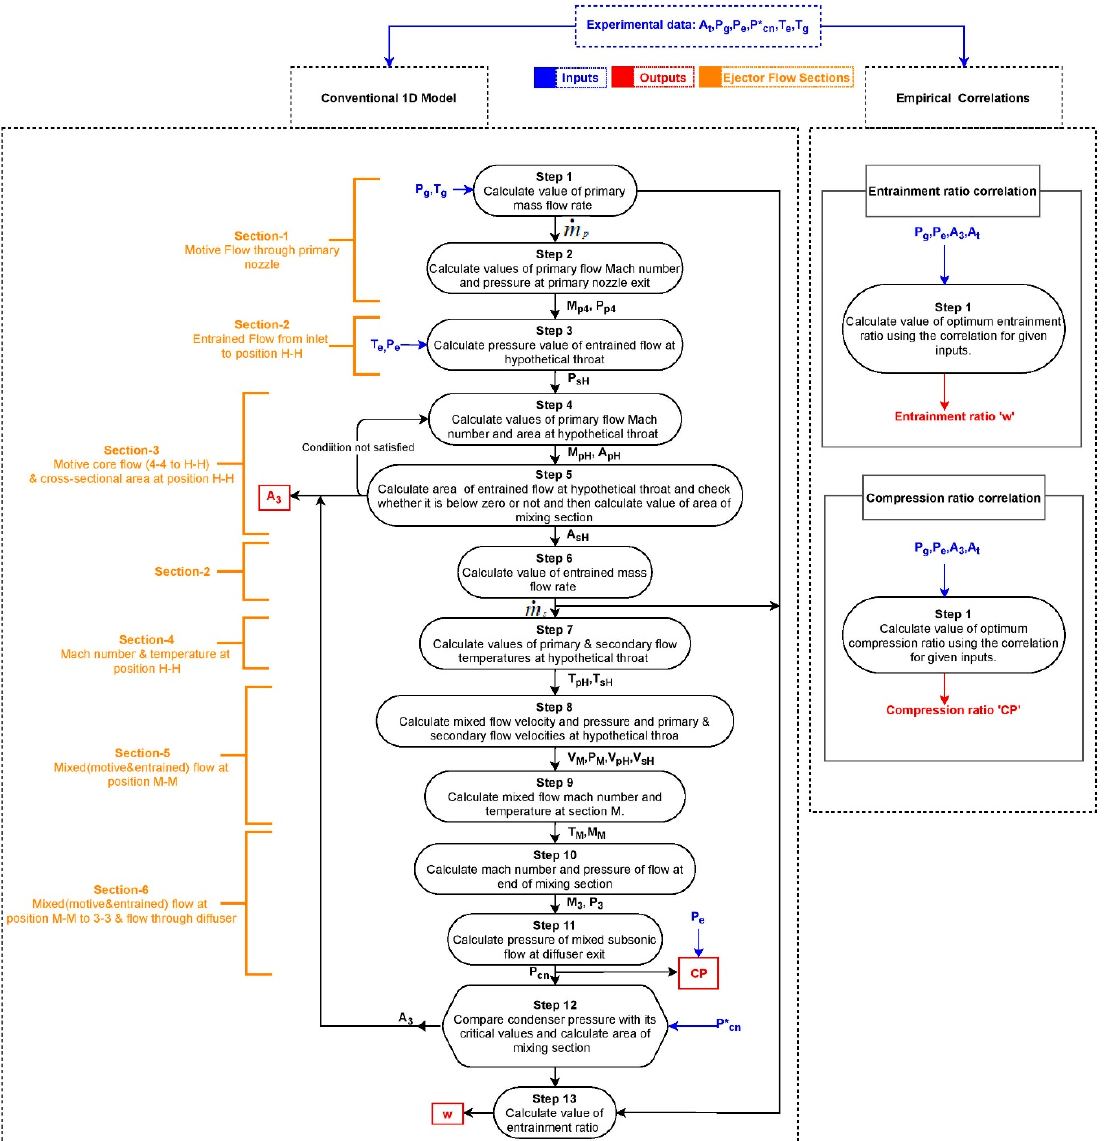
Figure 5. Comparative flowchart of ejector performance analysis 2.3. Computational fluid dynamics (CFD) model development.